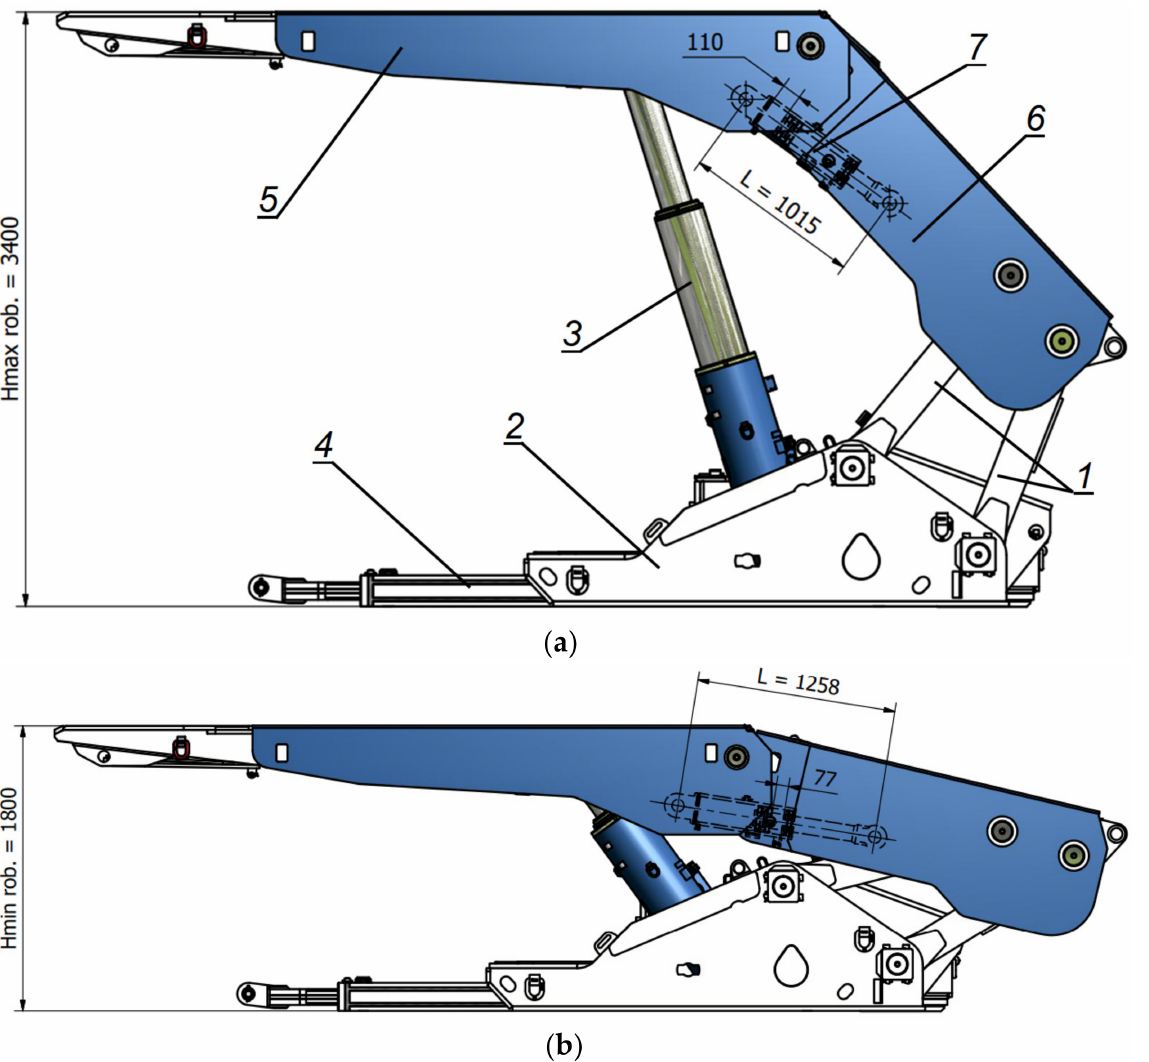
Figure 1. Scheme of a powered roof support with a ceiling support actuator: maximum expansion ( a ), lemniscate mechanism (1), floor base (2), hydraulic props (3), beam of sliding system (4), canopy (5), shield support (6), ceiling support actuator (7), and minimal expansion ( b